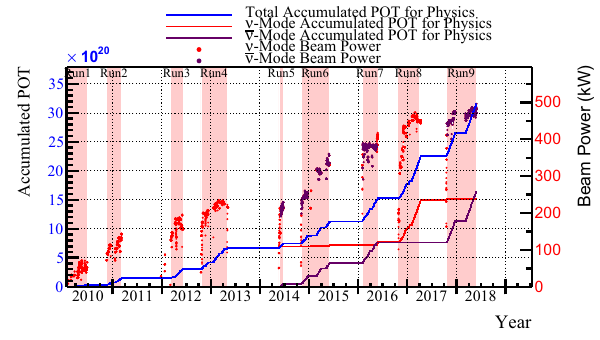
Fig. 52 The history of the delivered protons to the T2K experiment for analysis. The dots show the number of protons per pulse, and the lines show the integrated number of protons